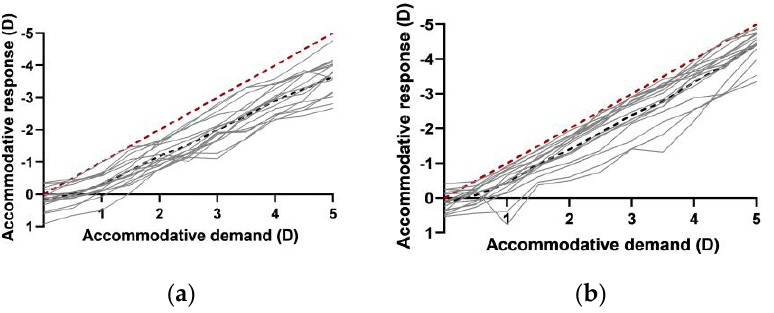
Figure 7. Accommodative response in terms of sphere plotted for each subject. ( a ) Pupil under natural conditions and ( b ) pupil under the effect of PHCl, for each subject. Both of them plot for the same pupil size, 4 mm. The dashed red line expresses the expected values of accommodative response. Additionally, the dashed black line expresses the mean values for each accommodative demand.